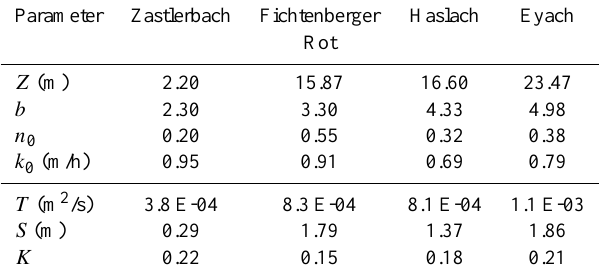
Table 6. Model performance for model evaluation using daily cli- mate and streamflow